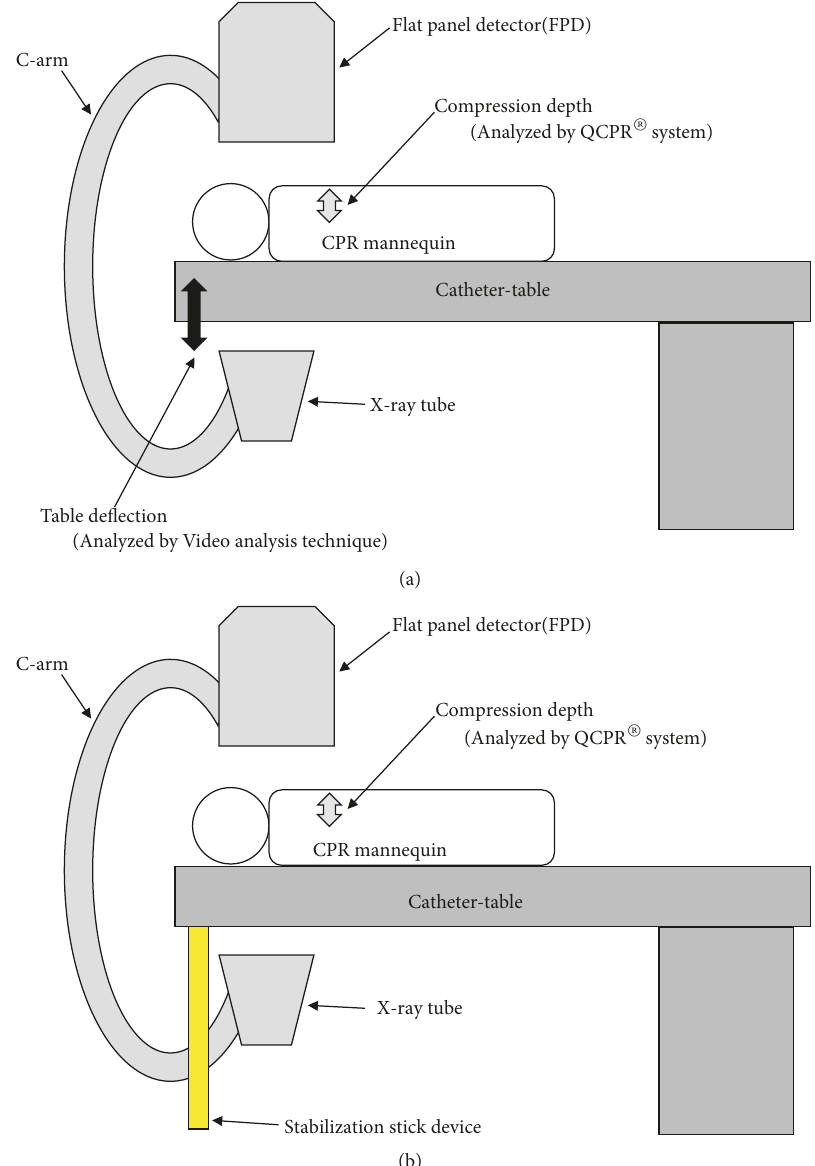
Figure 1: Diagrams of the study setting. (a) When the table-stabilizing stick is not installed under the cardiac catheterization table. (b) When the table-stabilizing stick is installed under the cardiac catheterization table. Compression depth was measured by the QCPR (cid:2) System, and table deflection was measured by video